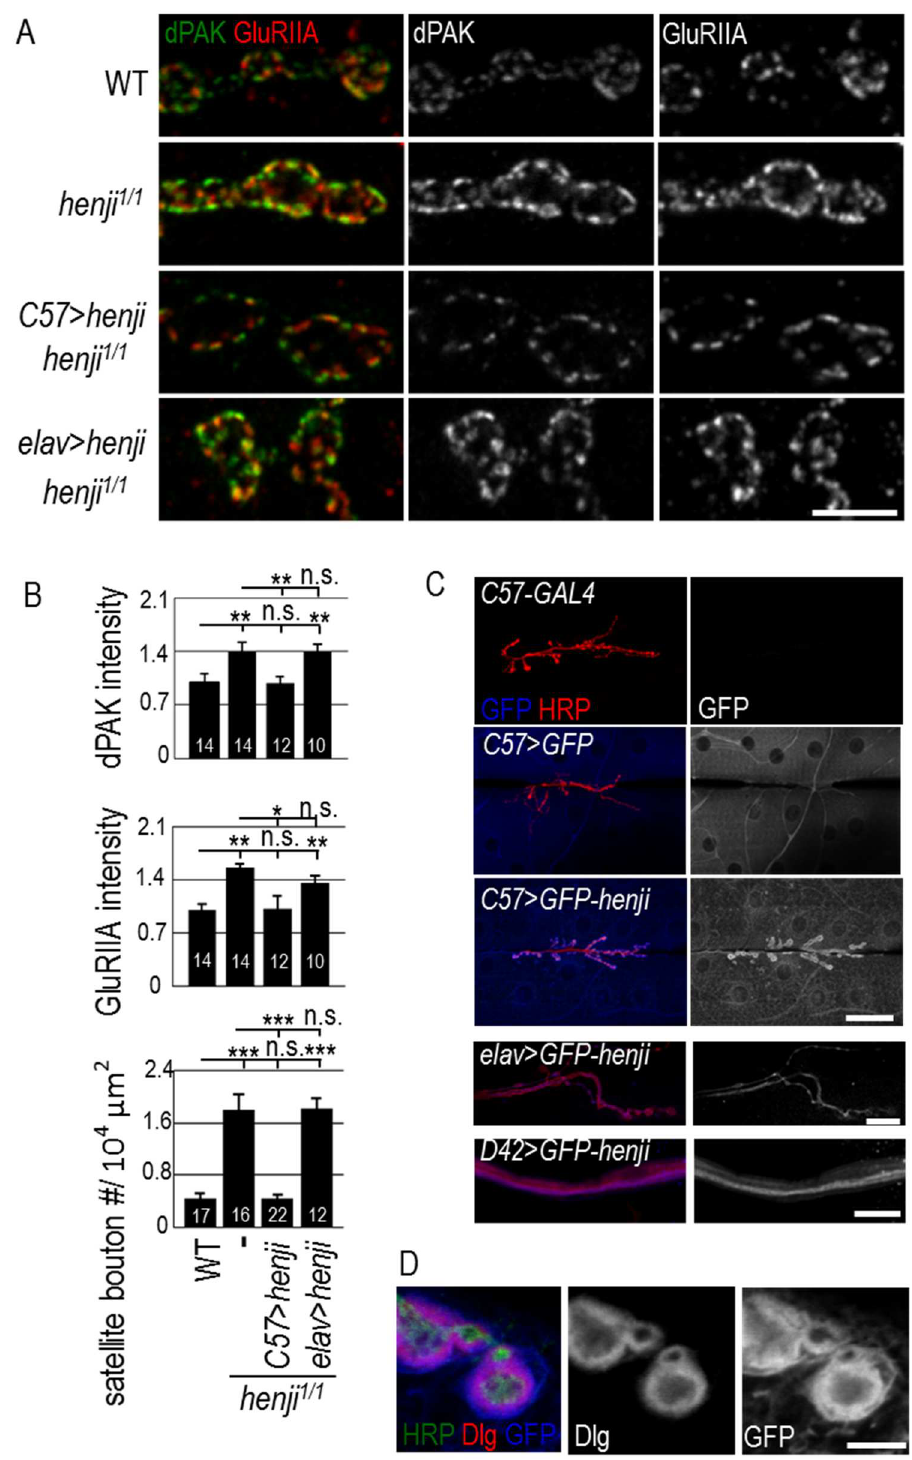
Fig 2. Henji functions in postsynapses. (A) Immunostaining of NMJs for dPAK and GluRIIA in WT, henji 1/1 , and UAS-henji transgenerescue of henji 1/1 by muscular C57-GAL4 ( C57 > henji ) or neuronal elav- GAL4 ( elav > henji ). Scale bar is 5 μ m. (B) Bar graphs show fluorescence intensities of dPAK and GluRIIA, and numbers of satellite boutons. dPAK intensity normalizedto HRP: WT, 1.00 ± 0.12; henji 1/1 , 1.41 ± 0.11; henji 1/1 C57 > henji , 0.98 ± 0.09; henji 1/1 elav > henji ,1.40 ± 0.10. GluRIIA intensity normalized to HRP: